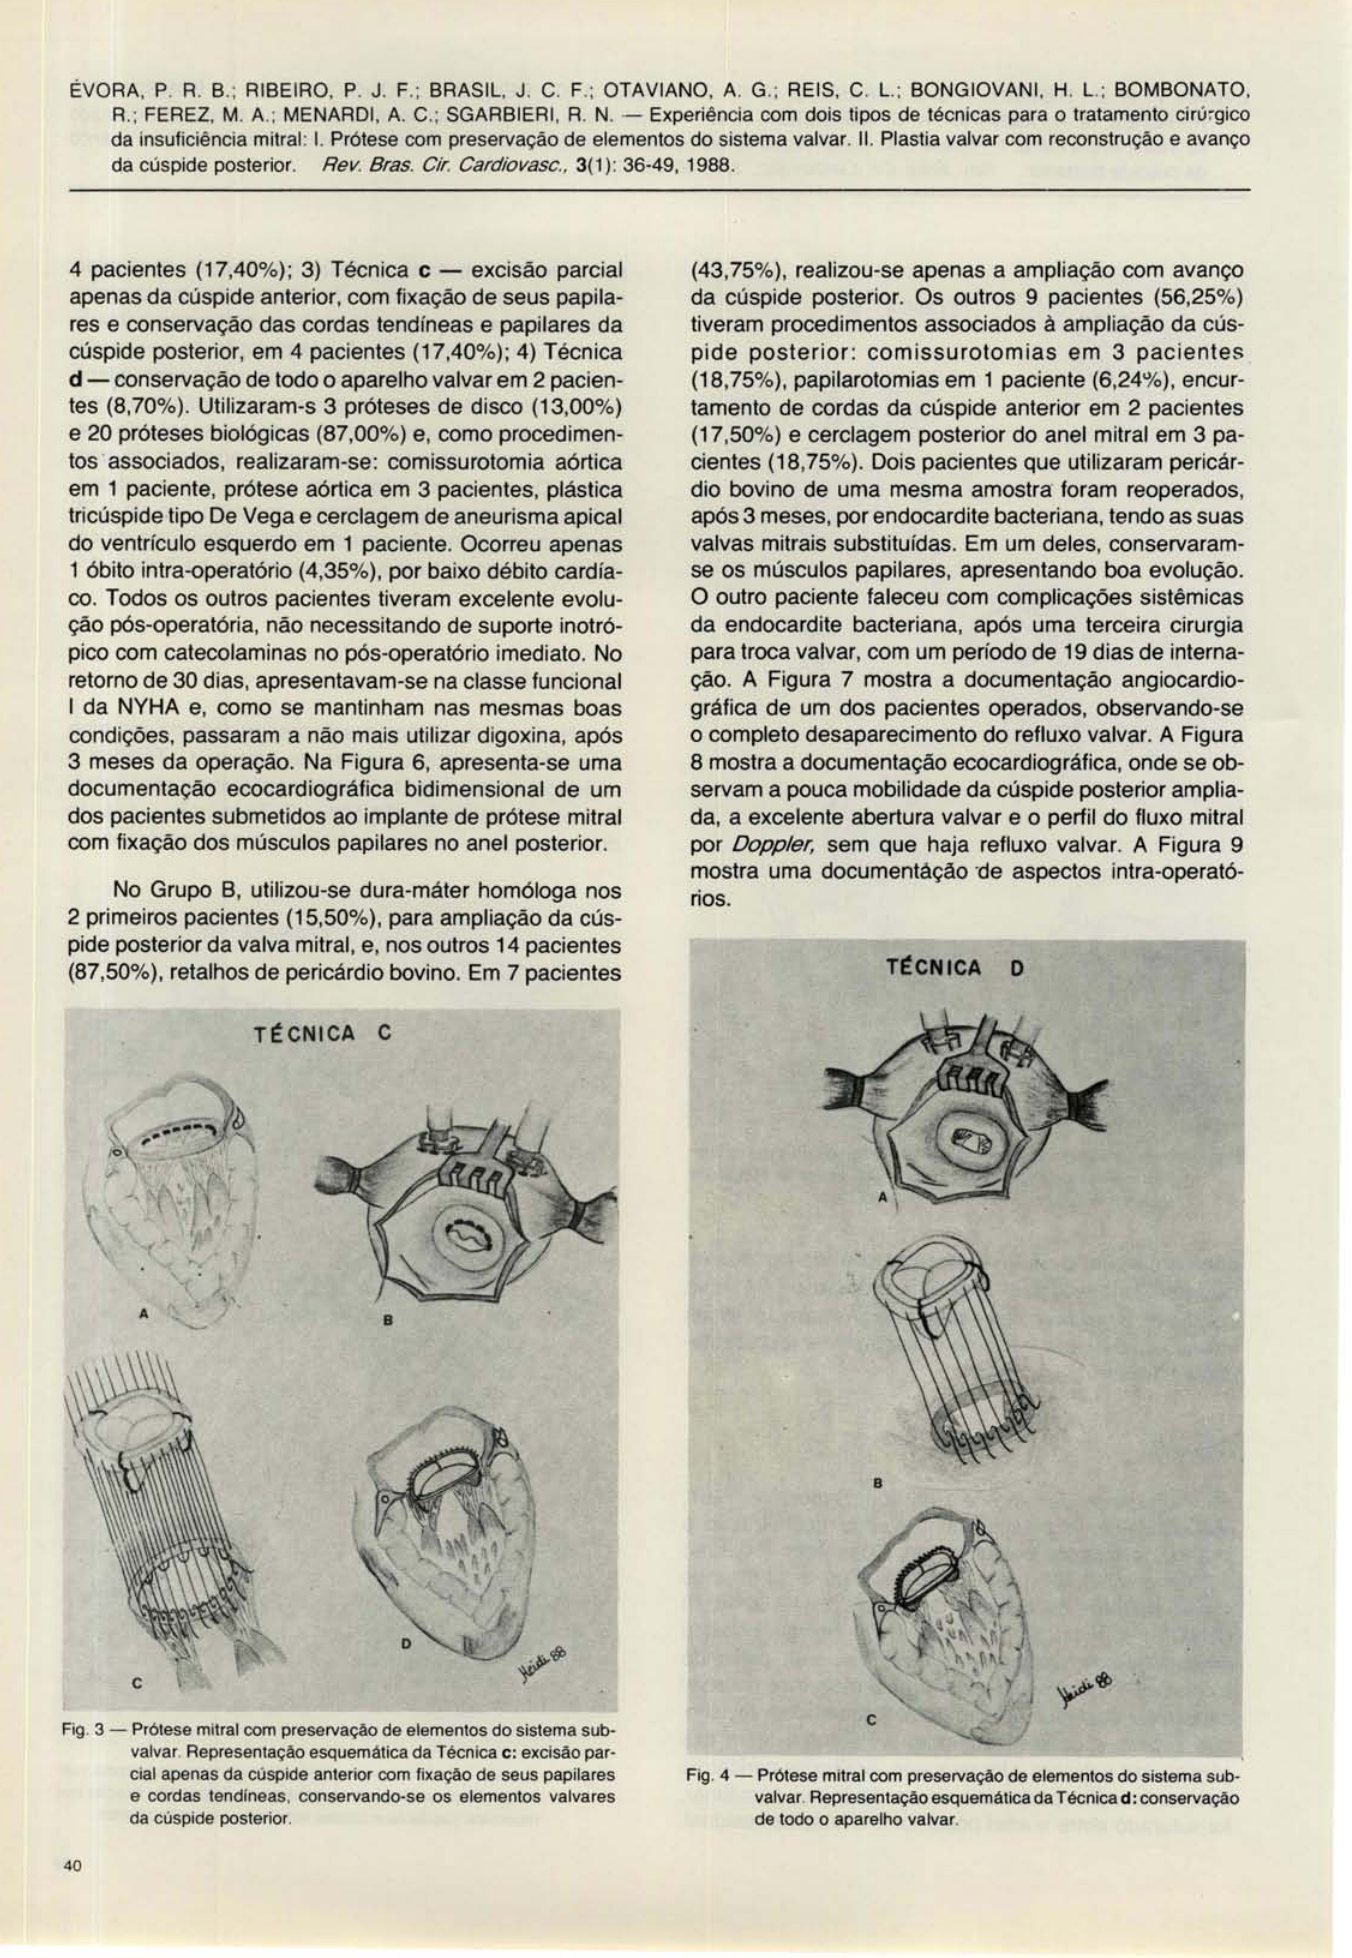
Fig. 3 - Prótese mitral com preservação de elementos do sistema sub valvar. Representação esquemática da Técnica c: excisão par cial apenas da cúspide anterior com fixação de seus papilares e cordas tendíneas, conservando-se os elementos valvares da cúspide posterior.